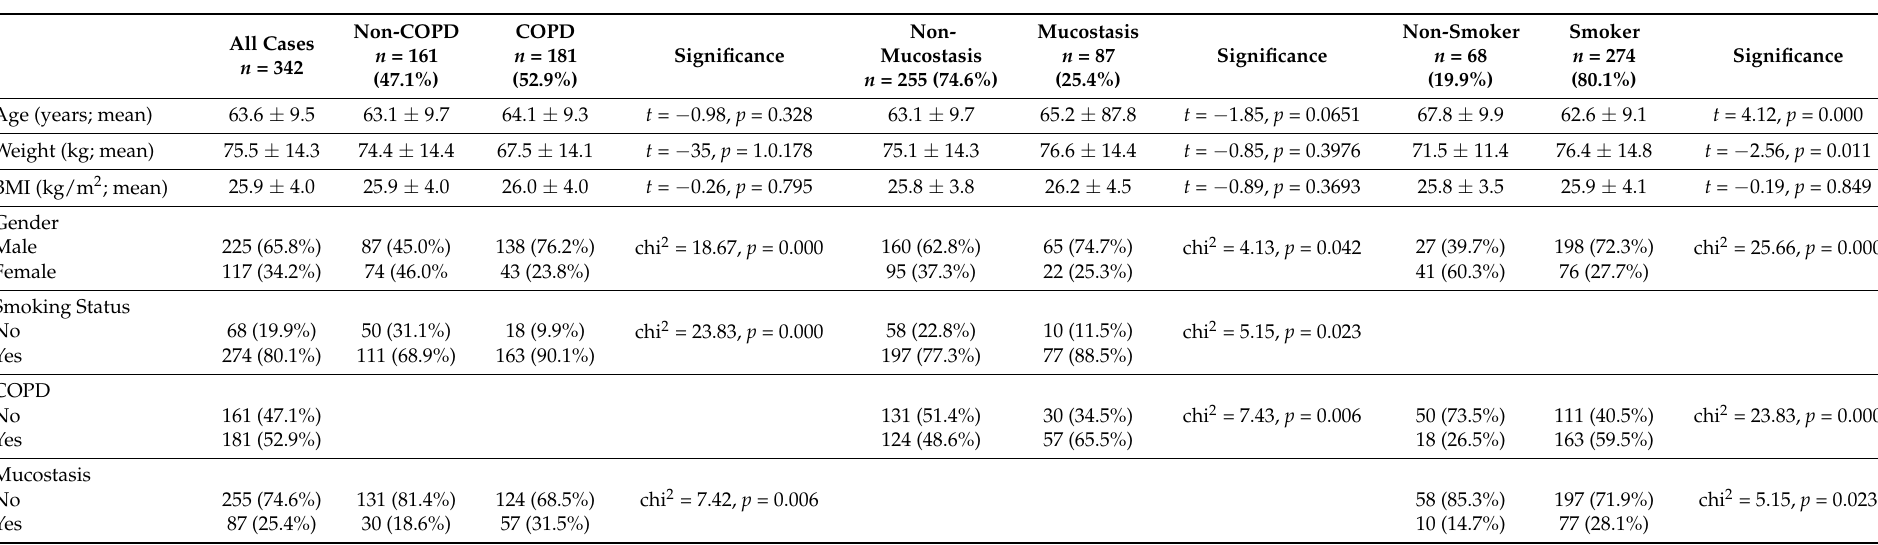
Table 1. Clinico-pathological characteristics of 342 patients undergoing curative resection for NSCLC focusing on demographic data. p values refer to t -test for continuous variables and to chi 2 for categorical variables. Abbreviations: COPD: Chronic obstructive pulmonary disease, BMI: Body Mass Index, kg: